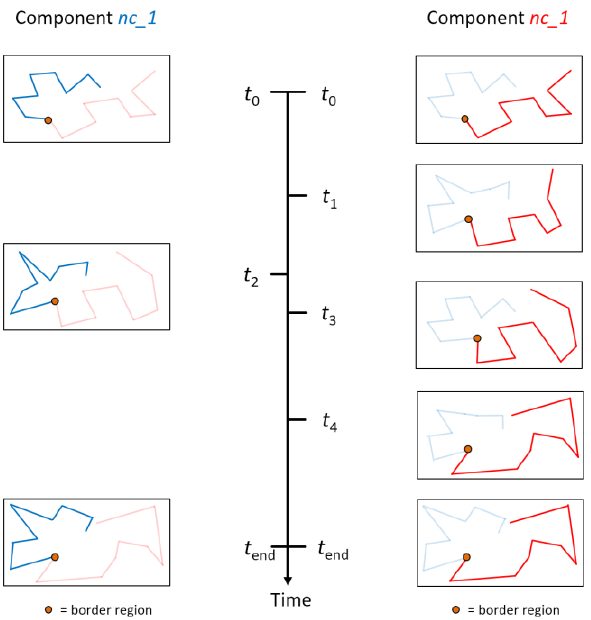
Figure 5. 1D-net consisting of two net components with different temporal resolutions, i.e. net component nc_1 with 3 time steps, net component nc_2 with 5 time steps